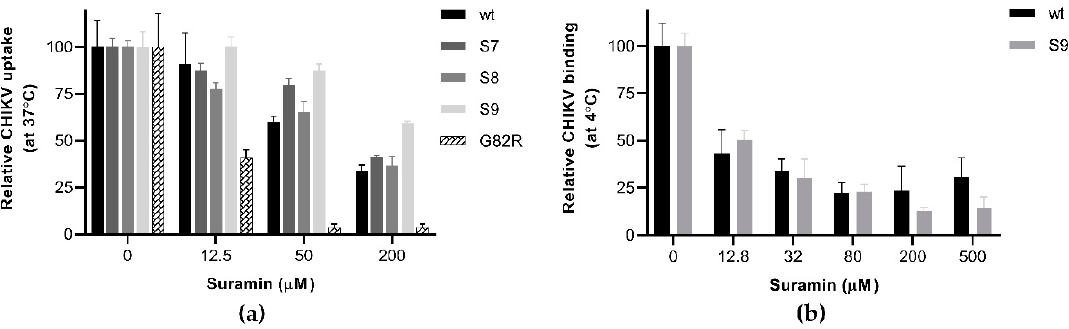
Figure 3. The effect of E2 mutations on suramin-resistance and the early steps of infection ( a ) Virus uptake and infectivity were determined based on a PRNT-like assay. Approx. 100 PFU of wt CHIKV and mutants S7, S8, S9 and G82R were incubated with Vero E6 cells for 1h in the presence or absence of increasing suramin concentrations. Afterwards the inoculum was removed, the monolayers were washed with PBS and overlay medium was added. After a three-day incubation, the cells were fixed and plaques were stained and counted. ( b ) The plaque number reduction assay was used to analyze synchronized attachment of wt CHIKV and variant S9 at 4 °C, in the presence and absence of suramin. After binding for 1 h in the cold, the inoculum and suramin were removed and replaced with overlay medium without suramin, and the rest of the procedure was performed as described under ( a ). The data represent the means ± the SD ( n = 3).